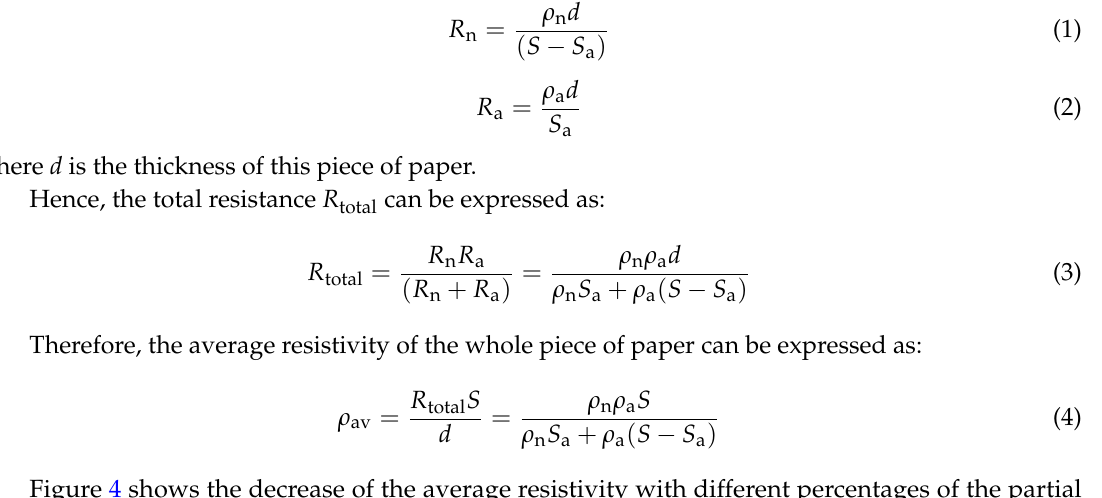
Figure 3. Idealized model of partial paper ageing. ( a ) Idealized model; ( b ) Equivalent circuit diagram.